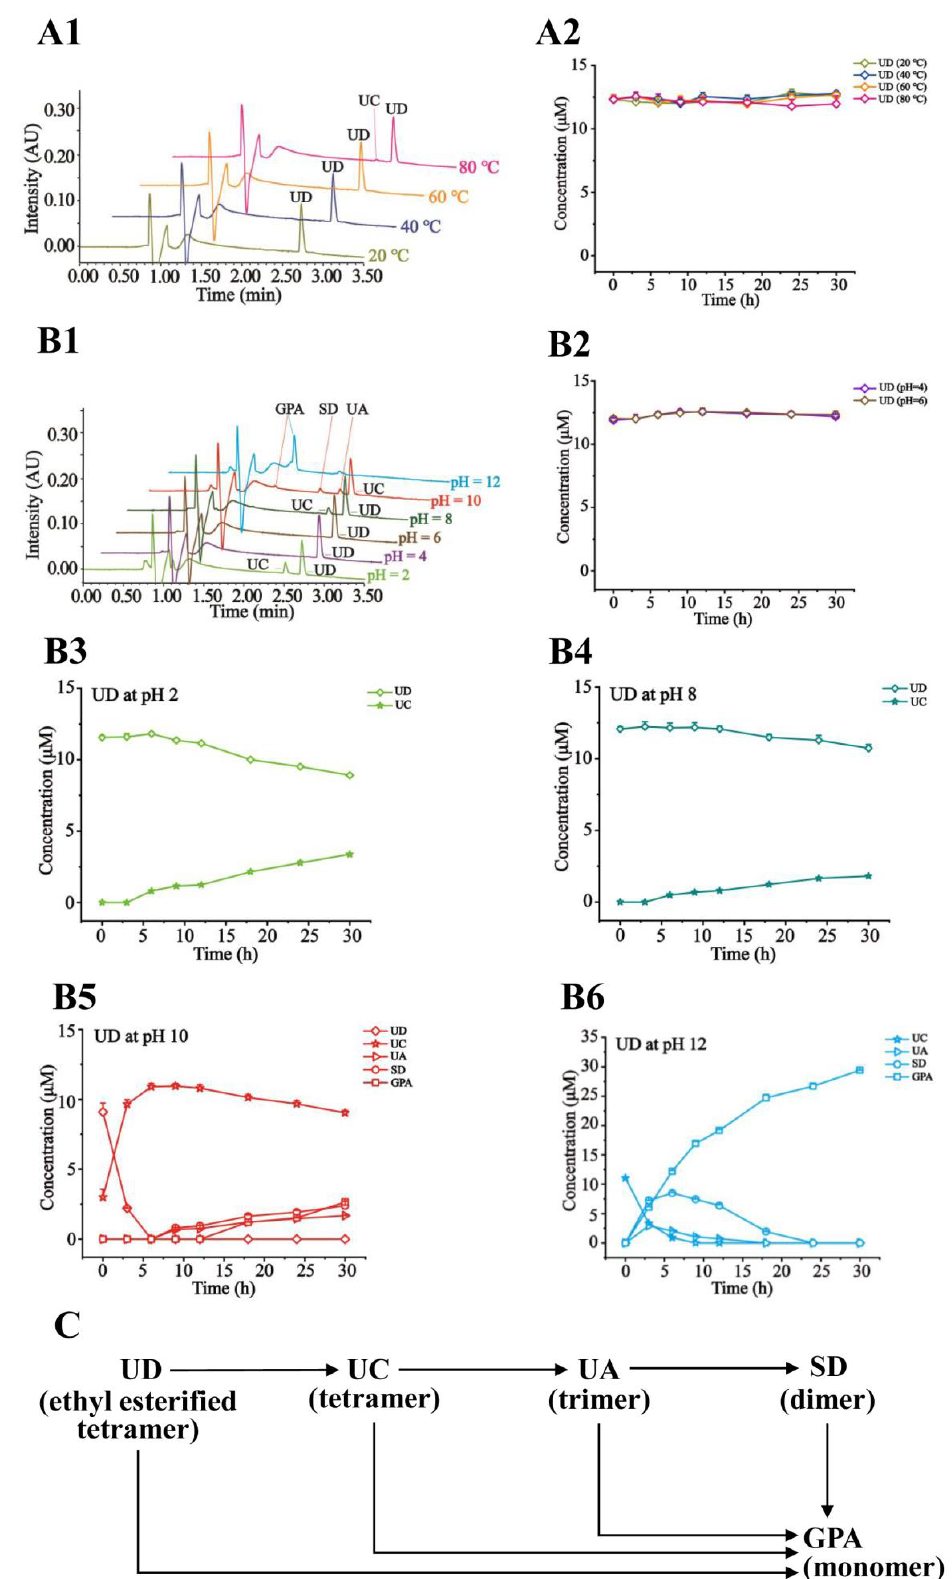
Figure 5. Representative chromatograms of UD in the tested solution exposed to different tempera- tures ( A1 ) and pH levels ( B1 ) after 24 h; Time–concentration curves of UD at different temperatures ( A2 ) and pH 4~6 ( B2 ); Time–concentration curves of UD and the degraded products at pH 2 ( B3 ), pH 8 ( B4 ), pH 10 ( B5 ), and pH 12 ( B6 ); The proposed degradation pathways of UD ( C